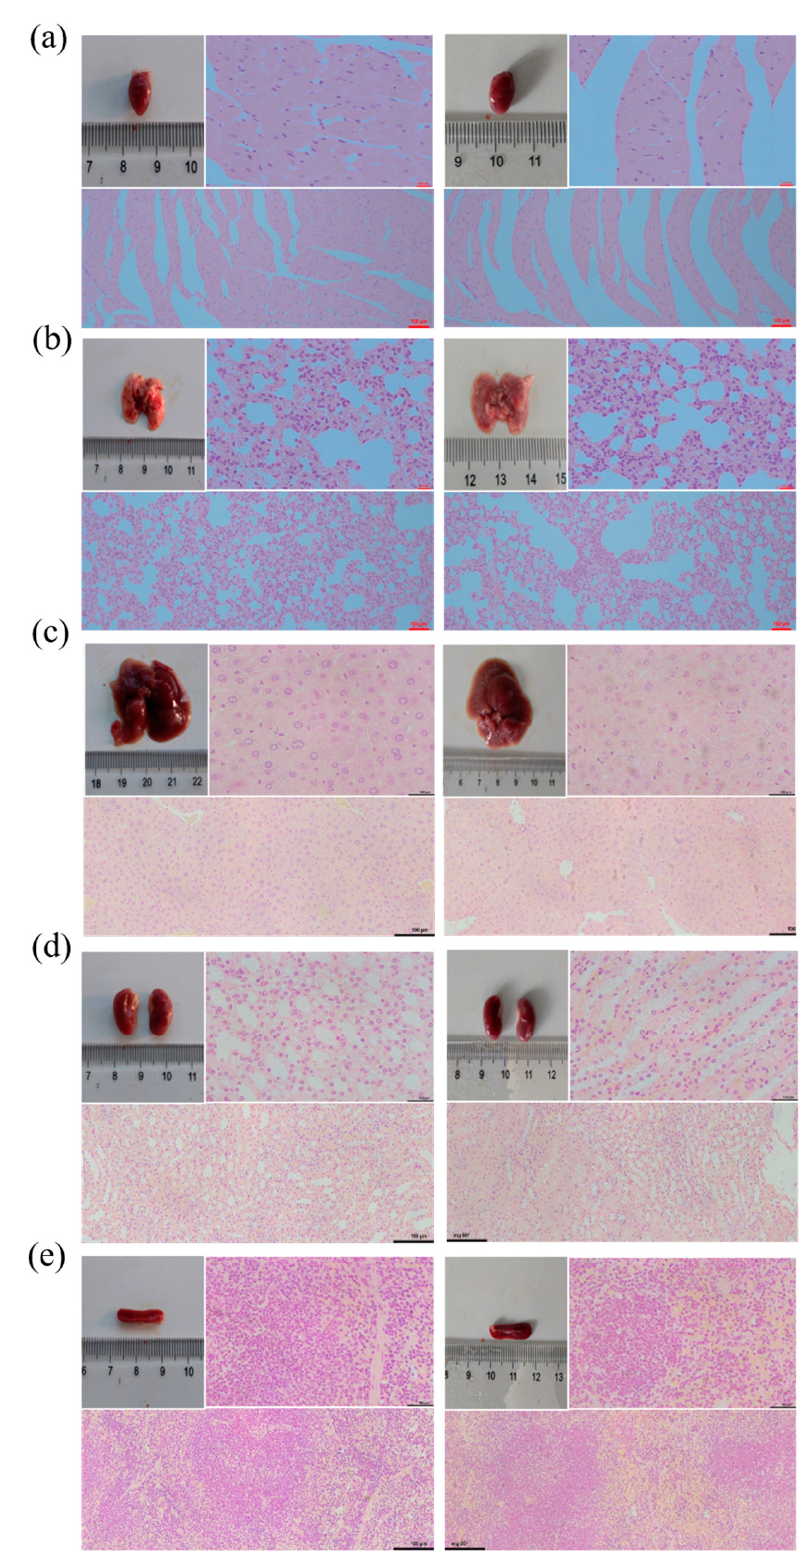
Figure 4. Effect of prodigiosin on the appearance of the heart ( a ), liver ( b ), spleen ( c ), lung ( d ), kid ‐ ney ( e ) tissues of mice (left images represent organs and tissues from the group prodigiosin group (PF), right images represent organs and tissues from the C group).